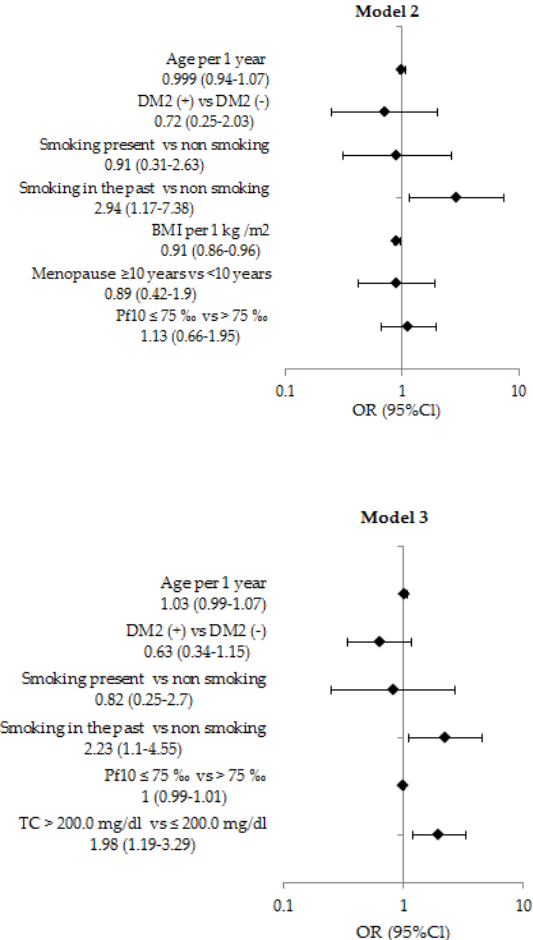
Figure A1. The results of a logistic regression analysis of the relationship OFF over the past 3 years and studied risk factors. Model 1—age-adjusted. Model 2 adjusted for age, DM2, BMI, smoking, duration of menopause, physical performance. Model 3 adjusted for age, DM2, smoking, physical performance, total cholesterol.